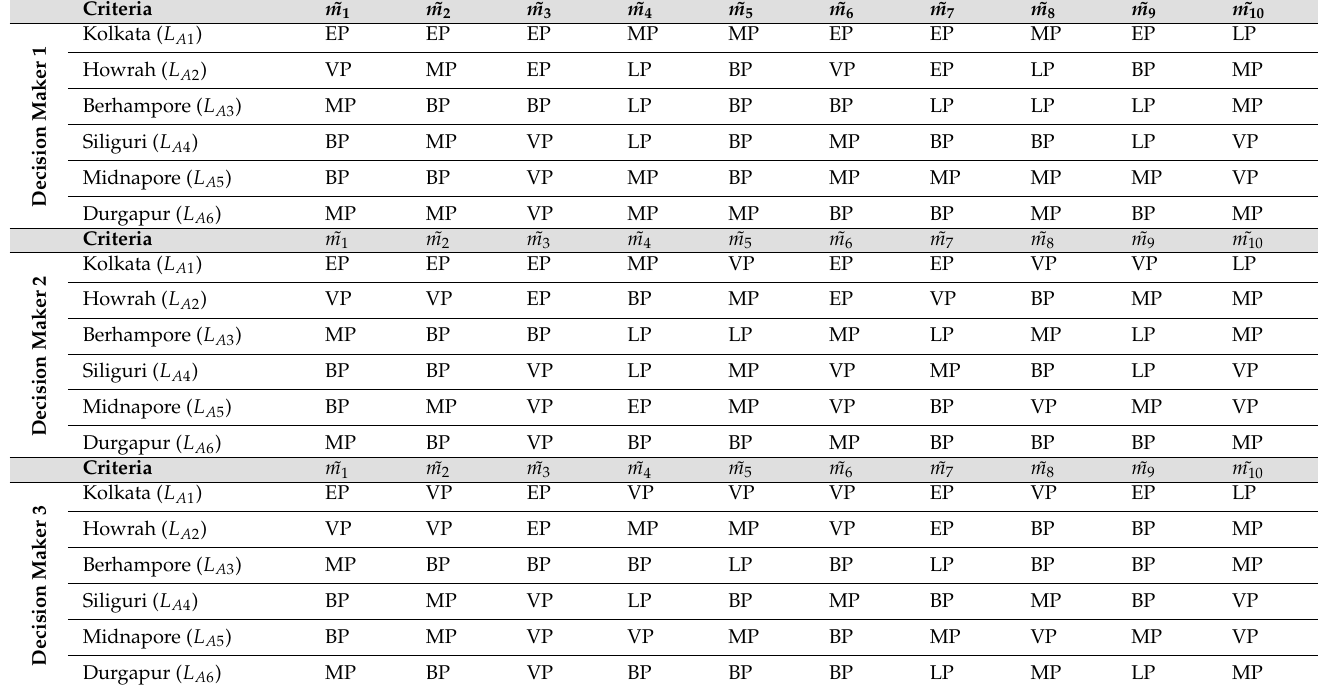
Table 15. Comparison matrix in linguistic terms between criterion’s and alternatives by three